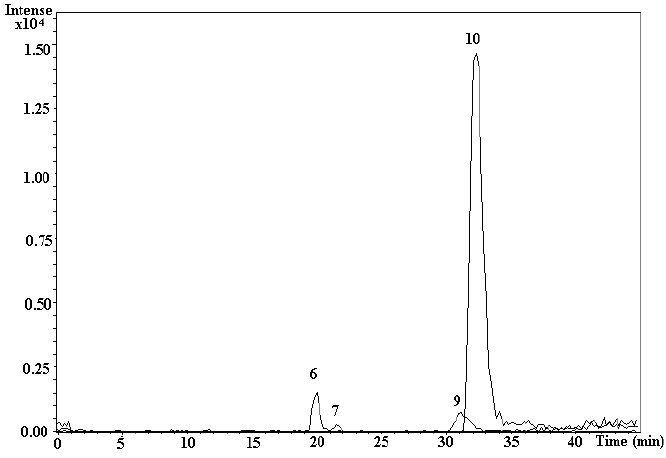
Figure 6. MRM chromatograms of putative four indoles in sugar cane juice by LC-MS/MS method. The LC-MS running conditions were described in Section